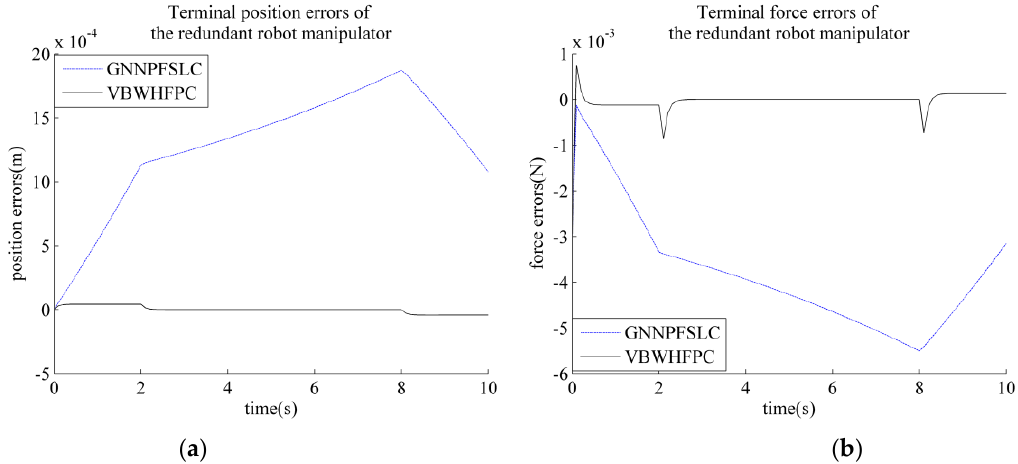
Figure 5. Control accuracy of the above two algorithms in the Z-axis direction ( a ) position control; ( b ) force control. Table 3. Position and force accuracies during the transport operation under constant force. |𝒆 | 𝑷 𝒎𝒂𝒙